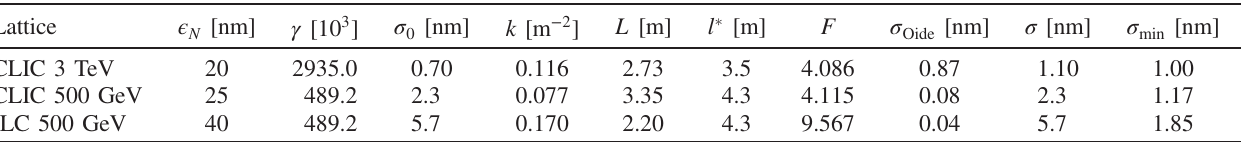
TABLE I. Vertical beam size and radiation beam size contribution for three lattices. ϵ N is the normalized emittance, ϵ N ¼ γϵ . Lattice